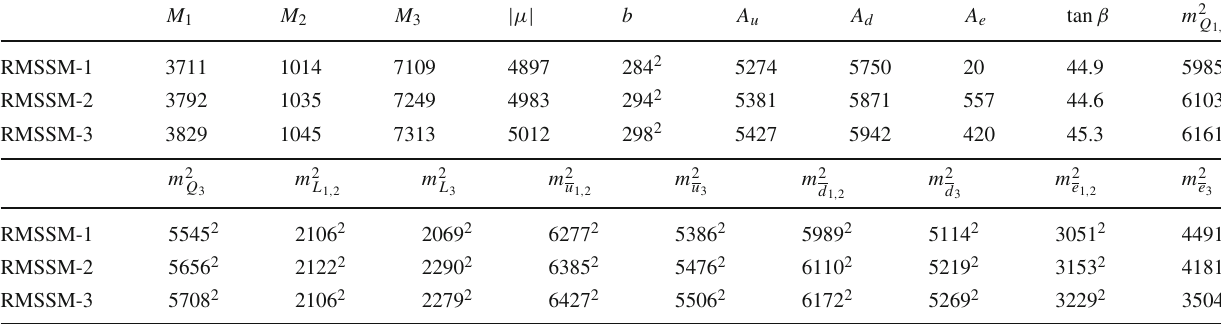
Table 10 Reduced MSSM predictions that are used as input to SPheno mass parameters are in GeV and rounded to 1 GeV